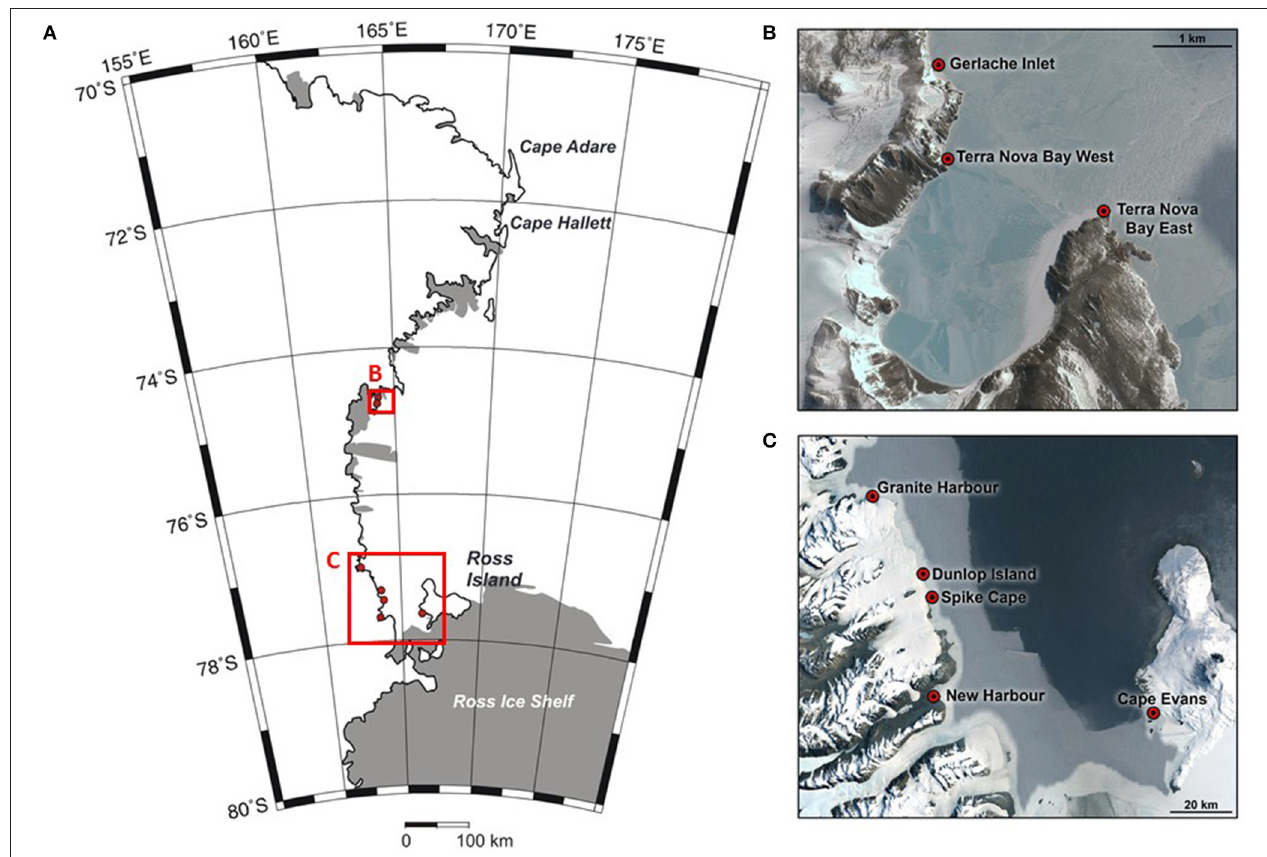
FIGURE 1 | Map of the Ross Sea region (A) , showing the sampling locations at Terra Nova Bay (B) , and the southern Ross Sea (C) . Three sites were sampled at each location. Credits for inset map data: (B) Google Earth, Digital Globe; (C) Google,